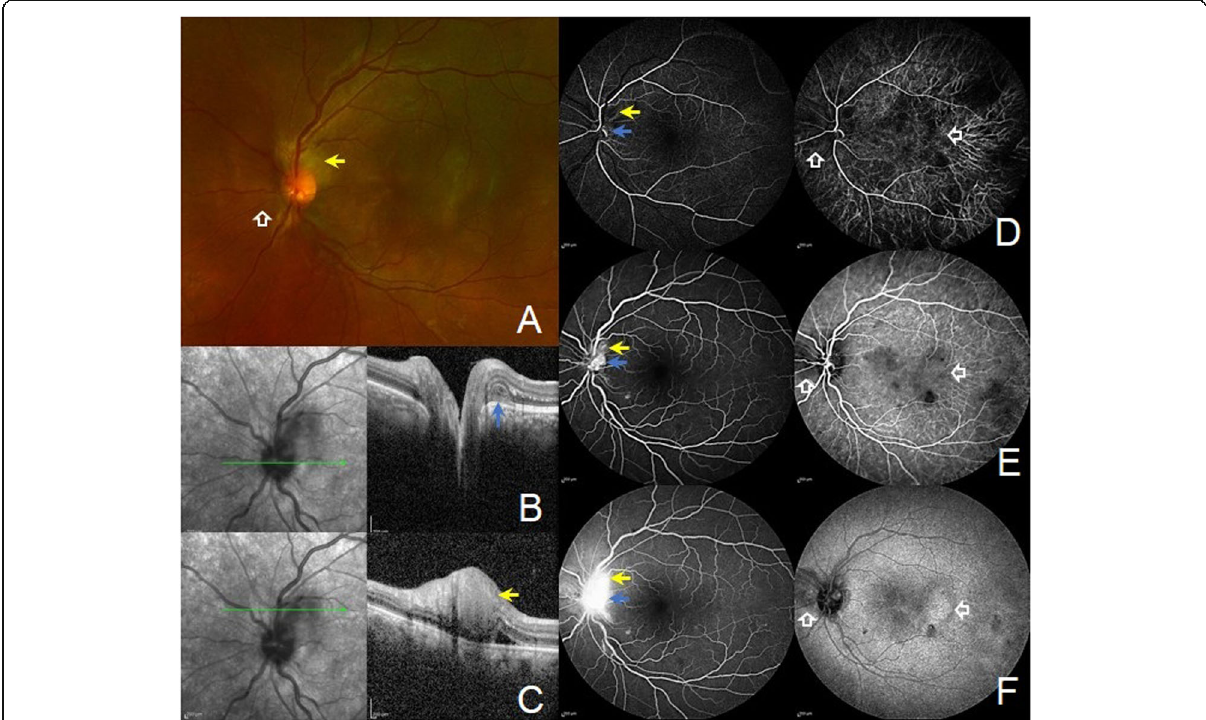
Fig. 3 Multimodal imaging findings revealing the presence of retinal and choroidal granulomas and peripapillary choroidal neovascular membrane (CNV). a The pseudocolour image with Optos, Daytona shows a grey-white lesion superotemporal to the optic nerve head (yellow solid arrow) and subtle elevated lesion nasal to the optic disc and temporal to the macula (white hollow arrows) suggestive of choroidal granulomas. b Horizontal line scan through the middle portion of the optic disc reveals the presence of peripapillary, subretinal choroidal neovascular membrane (blue solid arrow). c Horizontal line scan through the retina superior to the optic disc shows the presence of granuloma within the retinal layers (yellow solid arrow) and associated subretinal fluid. d – f Progressive phases of combined fluorescein (FA) and indocyanine green angiography (ICGA) of the left eye. The retinal granuloma, seen superotemporal to the optic nerve head, shows hypofluorescence in early phase with increasing hyperfluoroscence in the late phases of the FA (yellow solid arrow). On the ICGA, the lesion shows early hypofluorescence with mild staining of the lesion in the late phases (yellow solid arrow). The choroidal granulomas are not identified on the FA. The